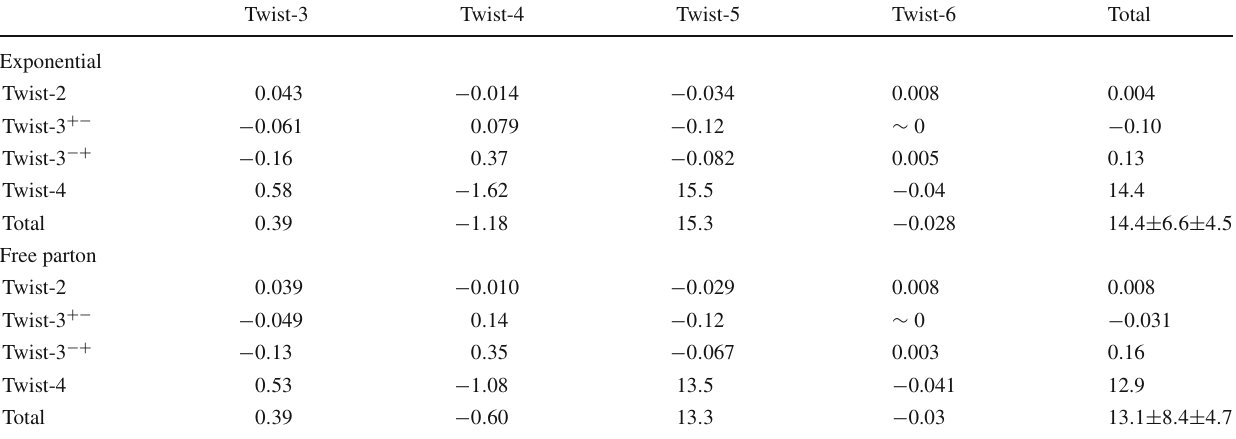
Table 10 The same as Table 4 but for the form factor g 2 ( 0 ) in unit of 10 − 3